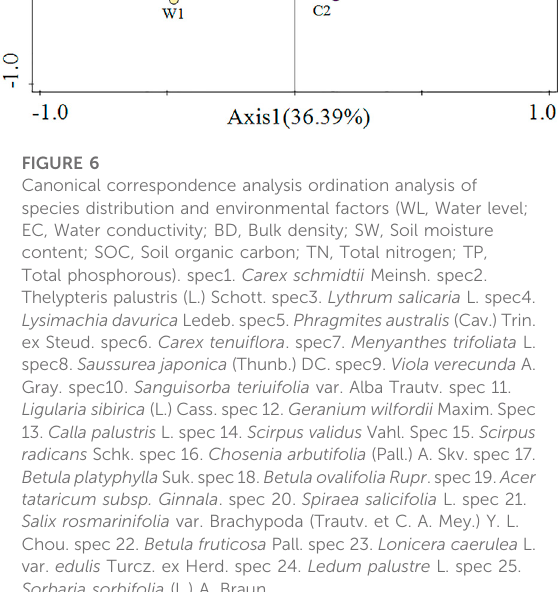
Betulaplatyphylla Suk.spec18. BetulaovalifoliaRupr .spec19. Acer tataricum subsp. Ginnala . spec 20. Spiraea salicifolia L. spec 21.